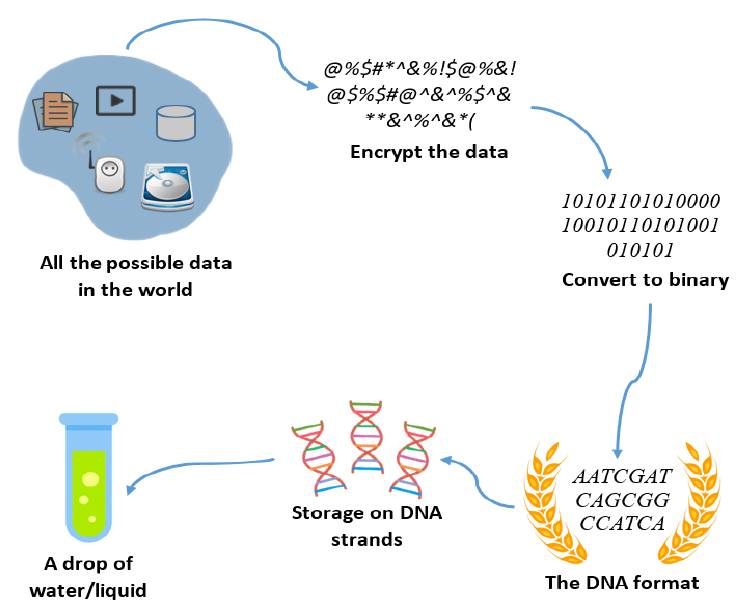
Figure 4. Encrypted data storage on a drop of